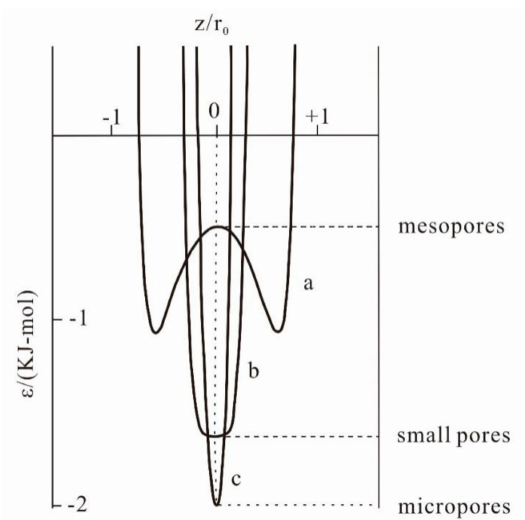
Figure 10. ( a ) d / r 0 = 1.60; ( b ) d / r 0 = 1.14; ( c ) d / r 0 = 1.00 ( ε : adsorption potential; z: The distance between the molecule and the parallel monolayer plane; d: Distance between two parallel single-layer planes; r 0 : The distance between the numerator and the parallel monolayer plane when ε = 0)